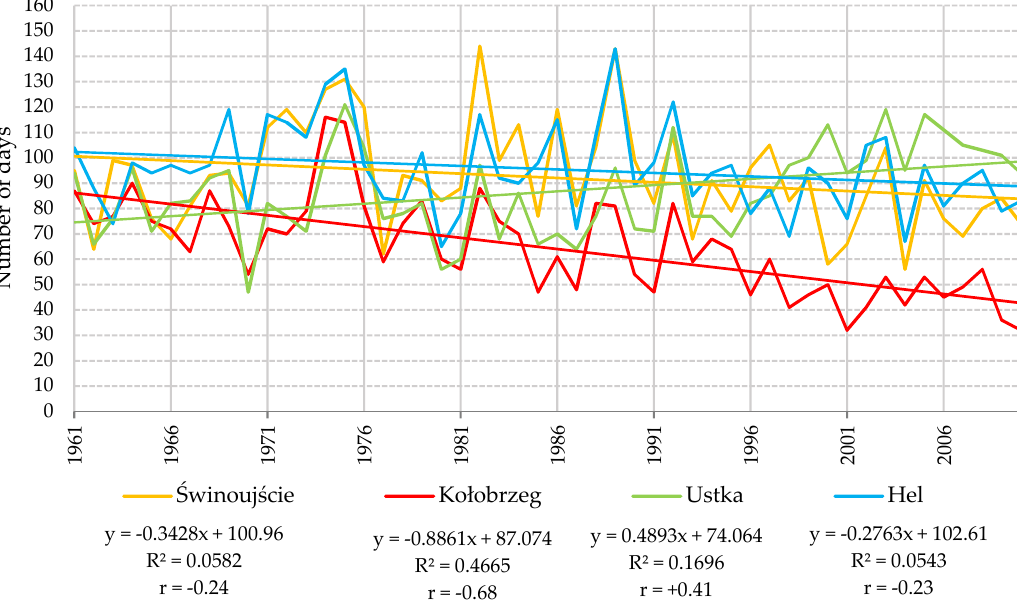
Figure 6. Annual trend of days with potentially favorable conditions for initiation of aeolian processes in the Polish Baltic coastal zone.